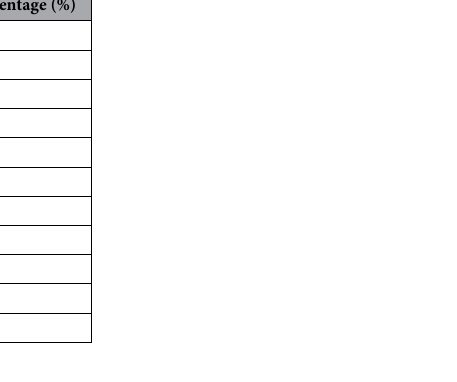
Table 1. Number of tests